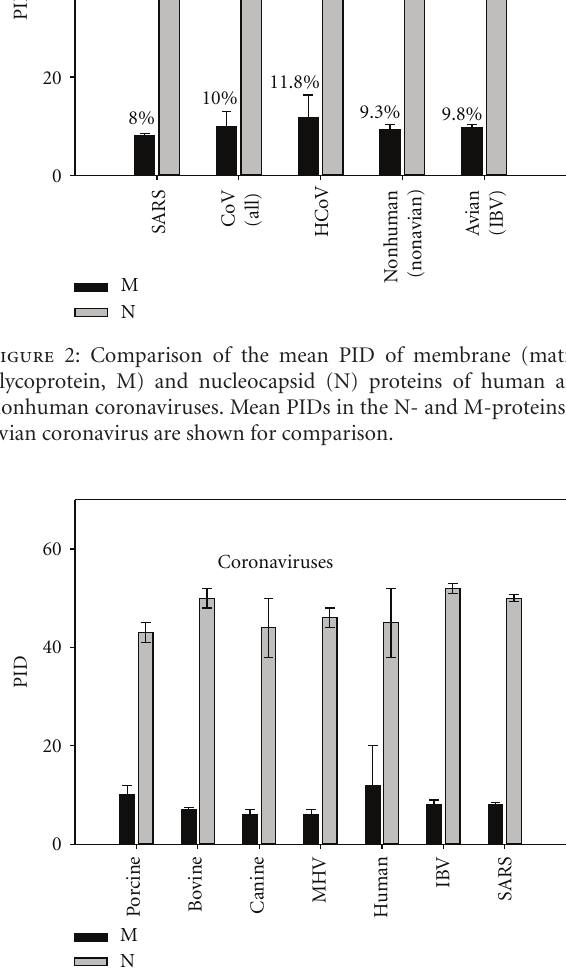
Figure 3: The mean PIDs of the M- and N-proteins of human coro- naviruses (HCoV) and the various animal coronaviruses including avian coronavirus.